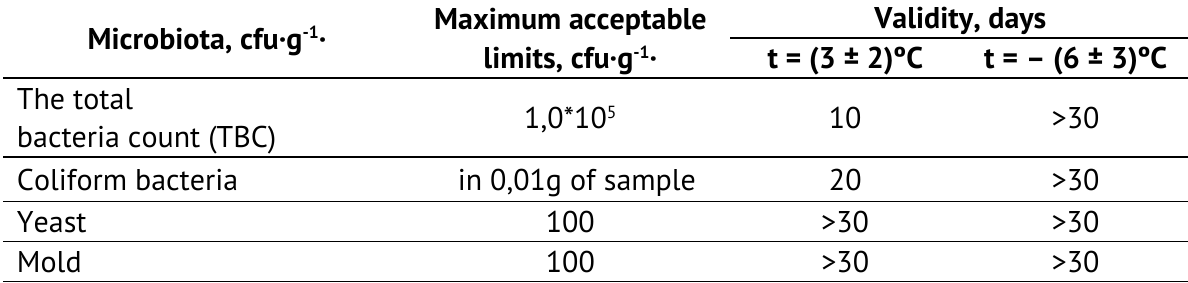
Dynamic evaluation of microbiota development in